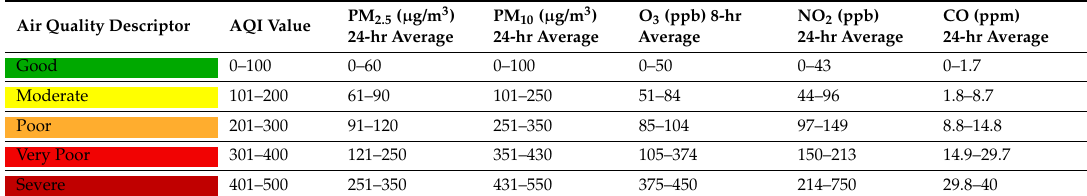
Figure 1. Flowchart demonstrating the array of stakeholders necessary to disseminate and act on an AQI advisory in Ahmedabad. Table 1. IITM-SAFAR air quality descriptors, AQI numeric values, and corresponding air pollution concentration thresholds and temporal averaging periods